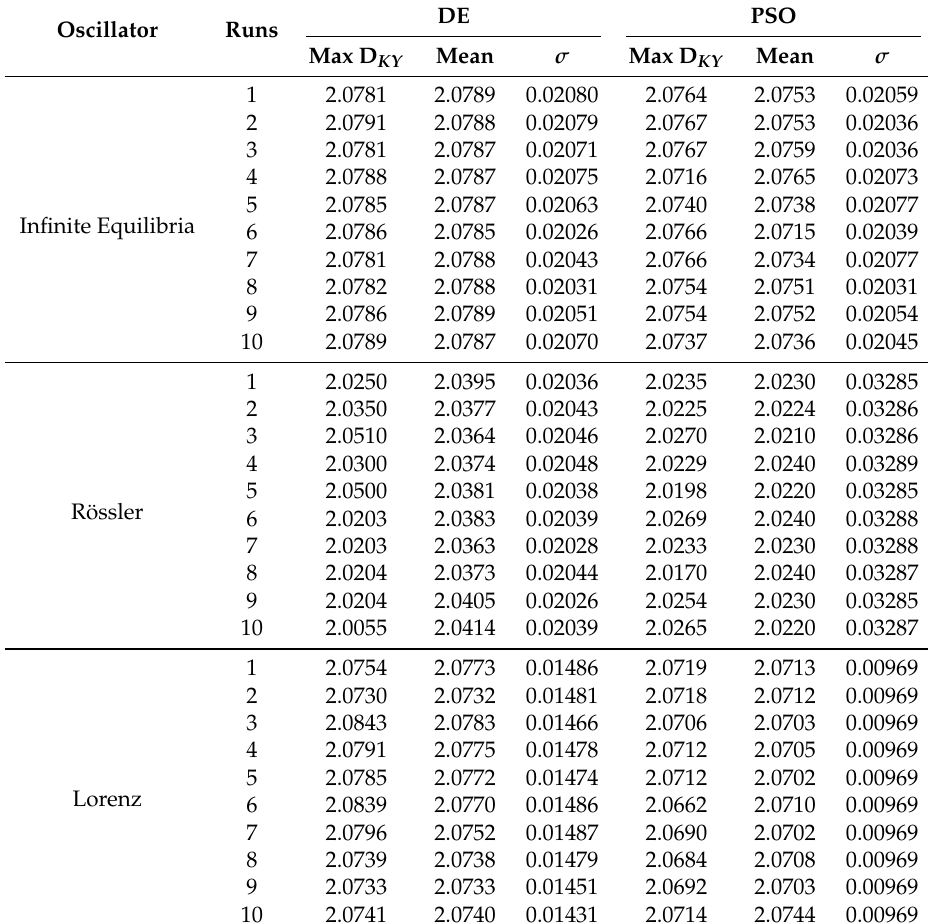
Table 3. Results of 10 runs performed by differential evolution (DE) and particle swarm optimization (PSO) for the three chaotic oscillators.